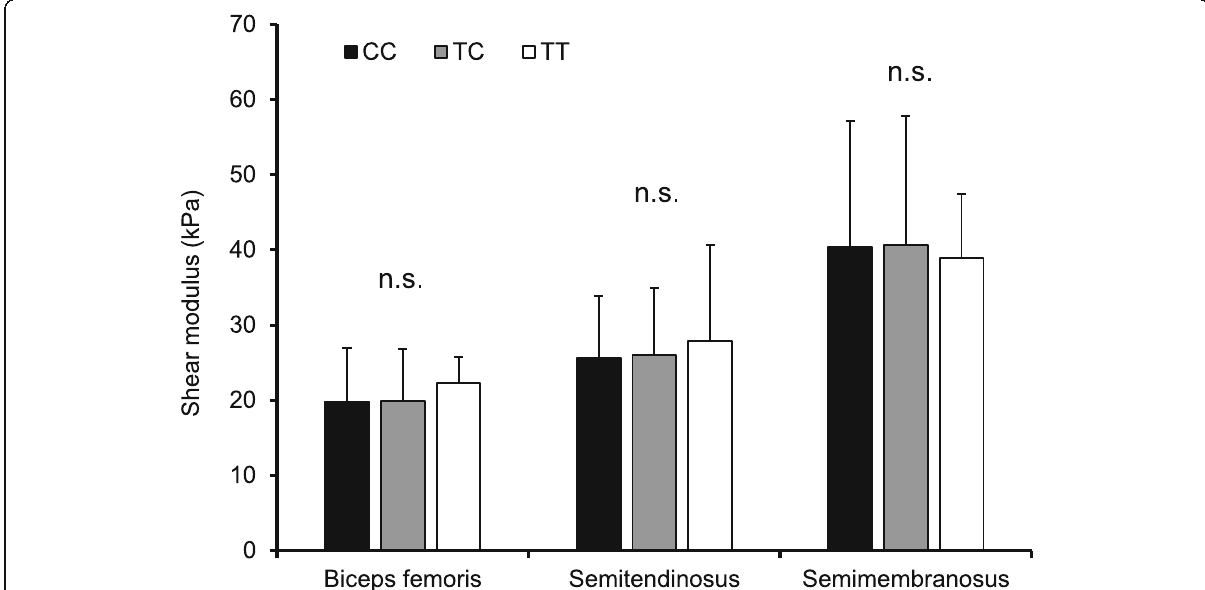
Fig. 1 Stiffness of the biceps femoris long head ( n = 353), semitendinosus ( n = 353), and semimembranosus ( n = 331) muscles by the COL5A1 rs12722 genotype. Data are expressed as the mean ±